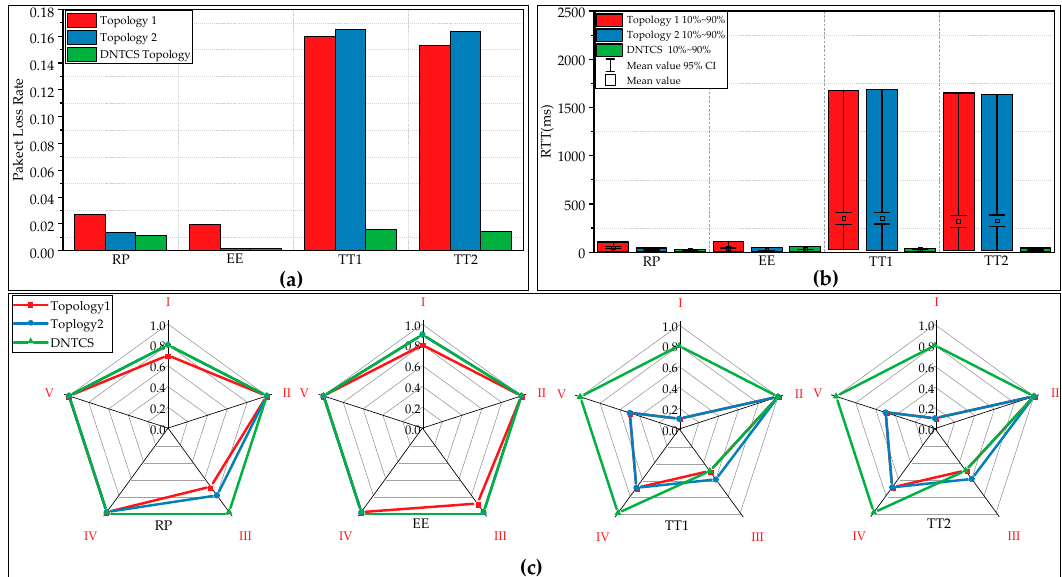
Figure 19. Results for Scenario 3.1 regarding the network performances of the mobile nodes. ( a ) Packet loss rate; ( b ) RTT; ( c ) normalized performance metrics.